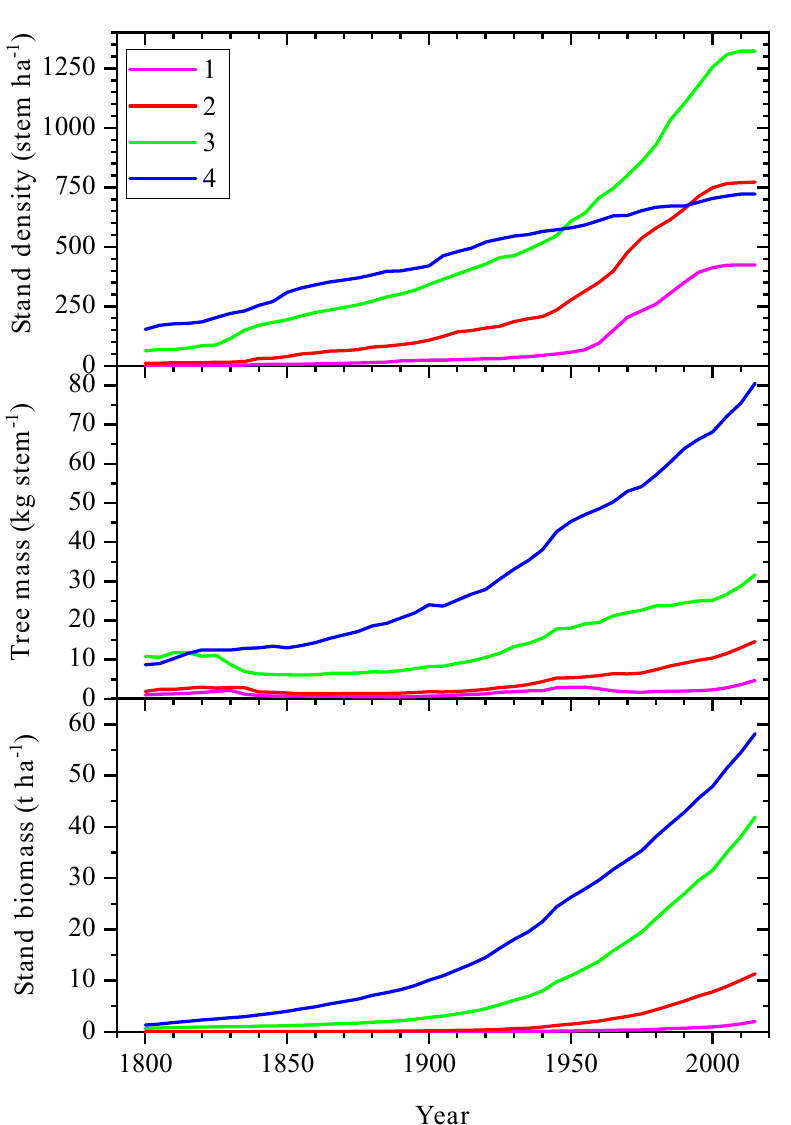
Figure 6. Changes of average trees mass, stand density, and biomass since the year 1800 on different levels in the forest–tundra transition on the slopes of the Sukhie Gory massif (Putorana Plateau) with Gmelin larch dominating: 1—sparse tree stand line; 2—open forest line; 3—contemporary closed forest line; and 4—historical (in 1950–1960s) closed forest line.